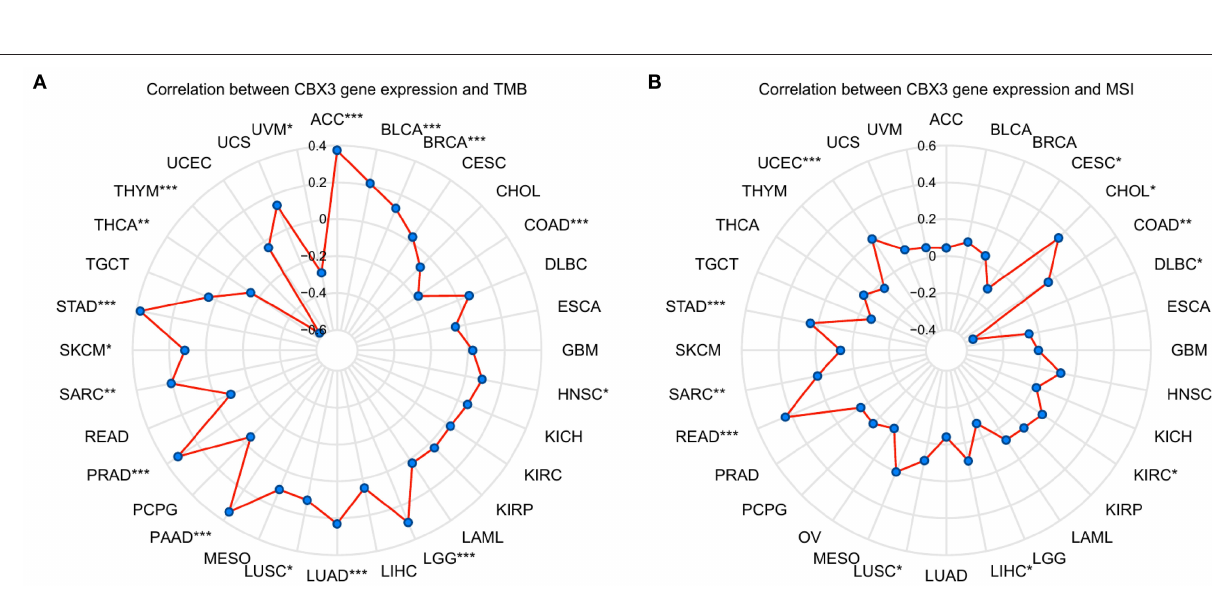
Frontiers in Medicine |